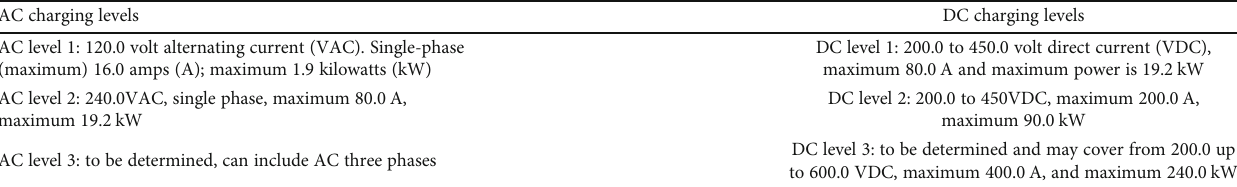
Table 1: Alternating current (AC) and direct current (DC) power levels [15].